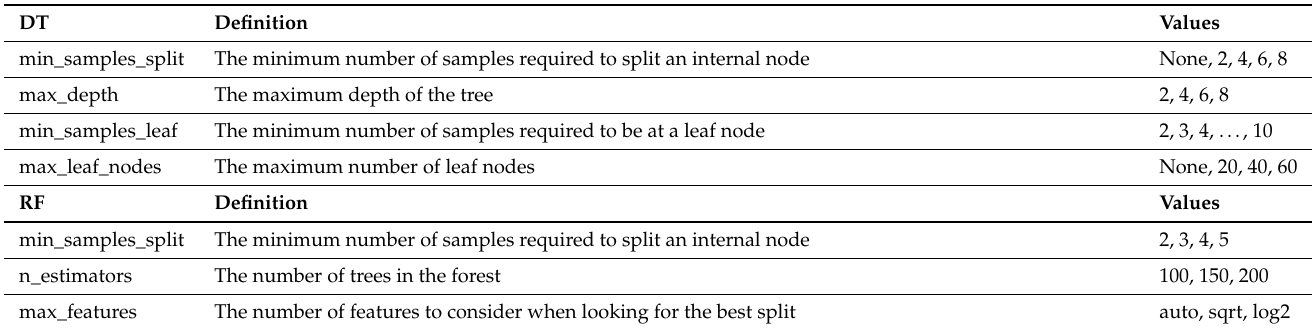
Table 7. Hyperparameters for the machine learning methods used in this